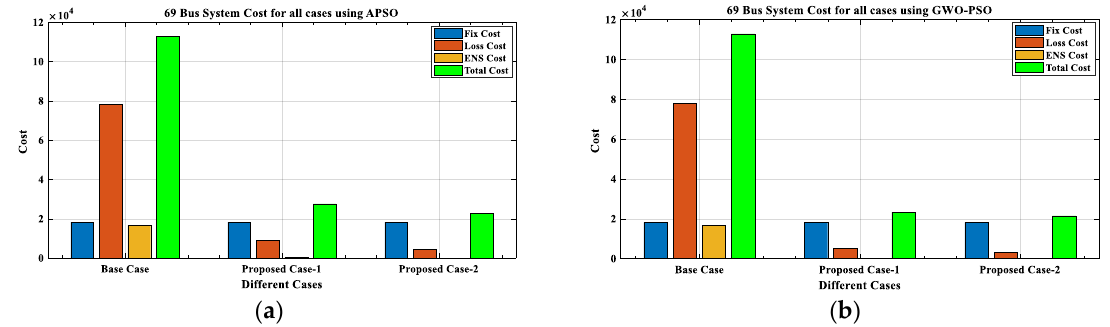
Figure 25. Cost for all cases of the 69-bus RDN; ( a ) APSO, ( b ) GWO-PSO.